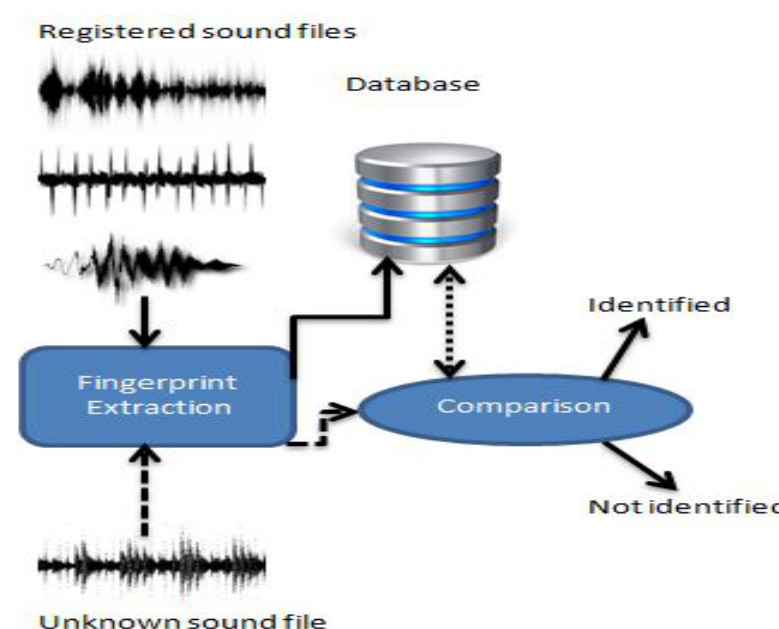
Fig. 1. General architecture of an acoustic identification system based on